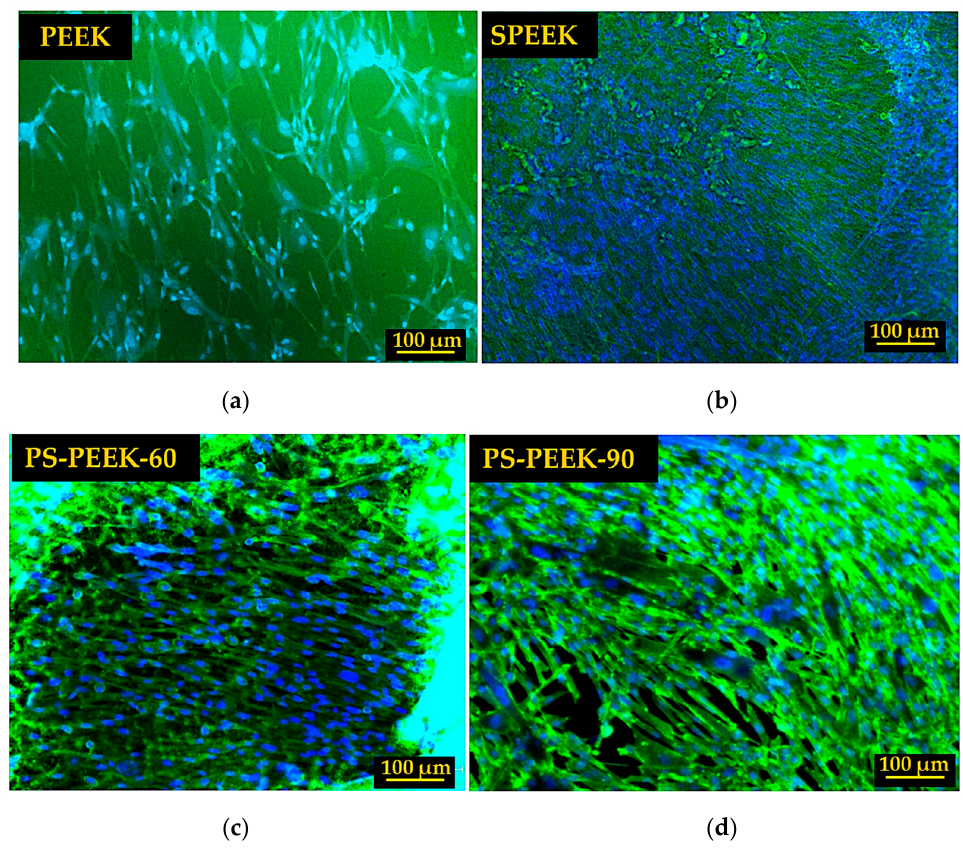
Figure 5. Cells stained with DAPI (blue) and phalloidin (green) adhered to the surfaces of PEEK ( a ), SPEEK ( b ), PS-PEEK-60 ( c ) and PS-PEEK-90 ( d ) samples after 7 days of growth.